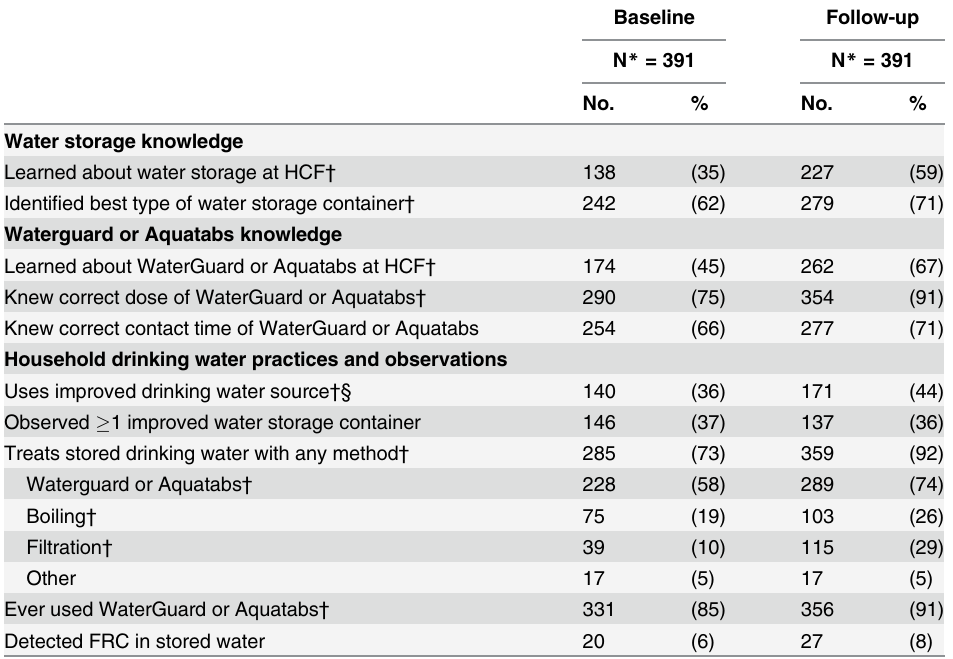
Table 3. Household knowledge, attitudes and practices regarding water treatment and water storage at baseline and follow-up, western Kenya, 2011 and 2012.